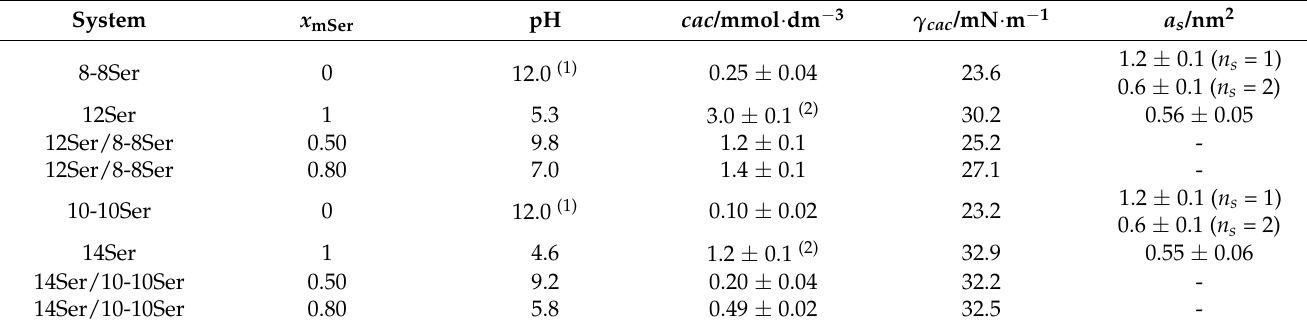
Figure 5. Surface tension plots at 25 ◦ C for the ( a ) 12Ser/8-8Ser and ( b ) 14Ser/10-10Ser catanionic mixtures and their respective neat surfactants. Table 1. Interfacial parameters obtained for the neat surfactants and catanionic mixtures with specific compositions, at 25 ◦ C, from surface tension